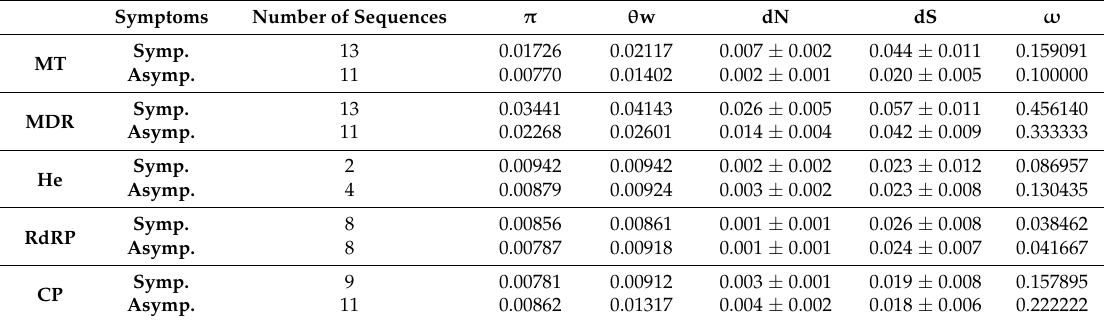
Table 6. Comparison of the population genetic parameters estimated for five coding regions of CSDaV isolates from symptomatic (Symp.) and asymptomatic (Asymp.) plants using the DnaSP and MEGA